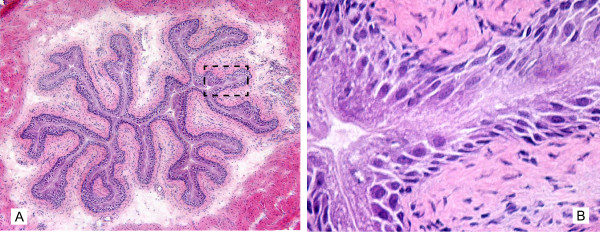
Morphology of the mouse urinary bladder secondary to rBCG-GFP instillation. 1.5 × 107 CFU of GFP-expressing rBCG in 200 microliters were instilled into the bladder of anesthetized mice, as described in material and methods. Twenty-four hours after instillation, the bladder were removed and frozen for morphological analyzes. H&E sections were photographed at 200× (Figure 12A) and 400× (Figure 12B). For composite H&E pictures (Fugure 12 A), at total of 9 photos were taken at 200× and automatically merged in Adobe Photoshop® CS3 extended [89]. Note that 200 microliters instilled into the bladder of anesthetized mice does not disrupt the urothelium integrity.